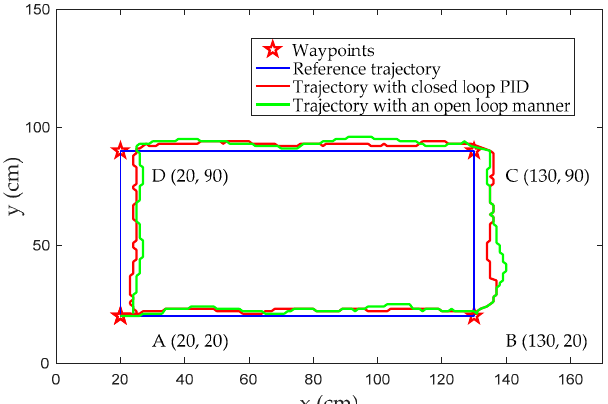
Figure 19. Snapshots of waypoint tracking (view of the global camera). ( a ) at point A; ( b ) at point B; ( c ) at point C; ( d ) at point D.